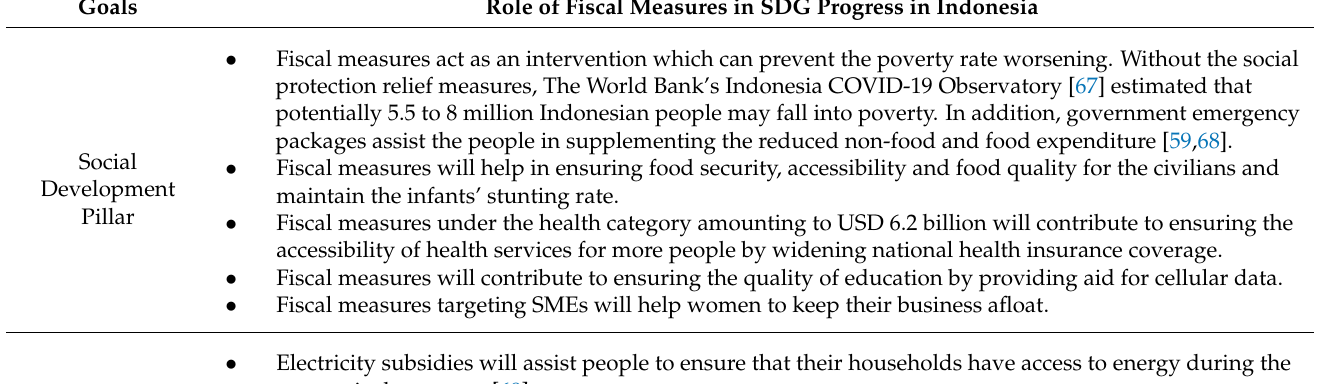
Table 2. Role of fiscal measures in SDG progress in Indonesia.